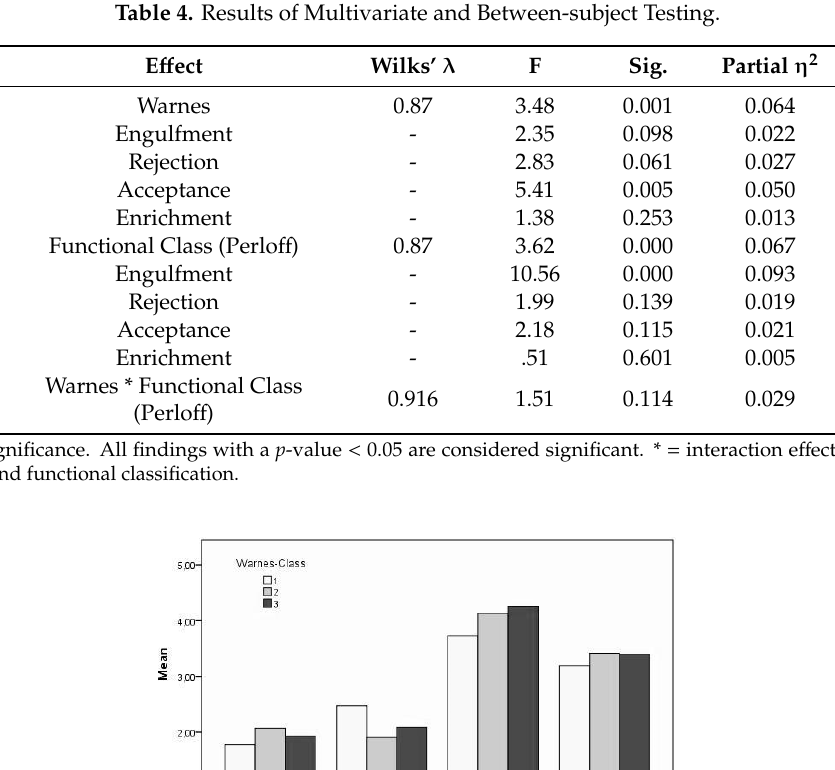
Figure 2. Mean Differences in Illness Identity by Warnes Classification [19].